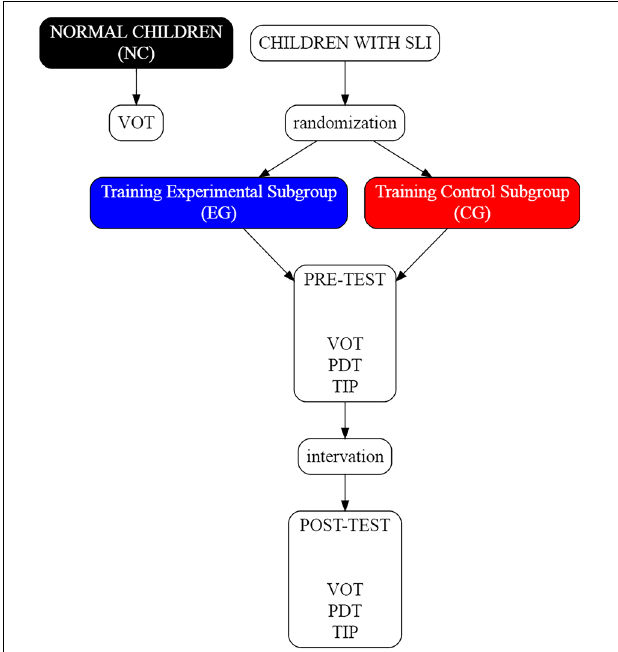
FIGURE 3 | Schema of the study. In NC the VOT task was performed once, whereas in EG and CG subgroups all three assessment tasks: VOT, Phoneme Discrimination Test (PDT), and temporal information processing (TIP) were conducted twice, i.e., before and after the intervention.